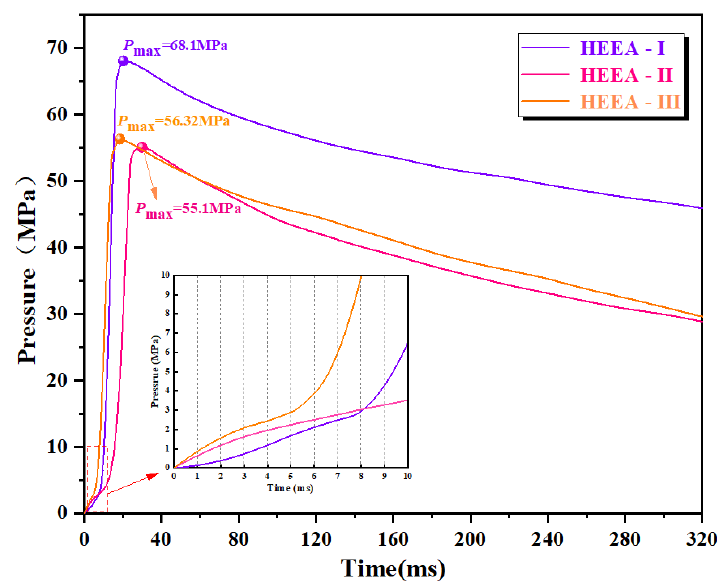
Figure 11. P- t curve of high-energy expansion agent admixture. The zoom-out in Figure 11 is the P- t curve over 10 ms of HEEA deflagration. At 0~4